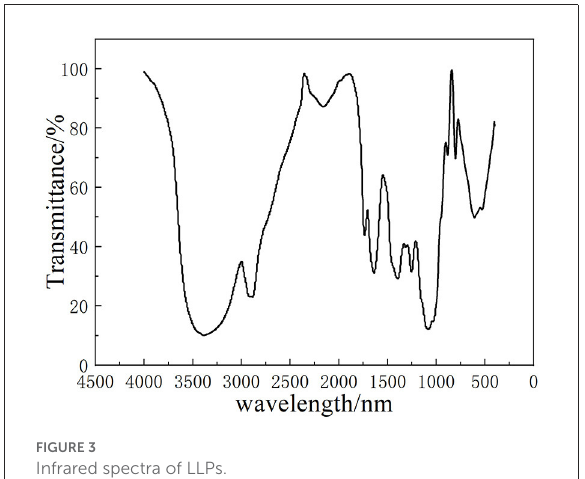
FIGURE3 Infrared spectra of